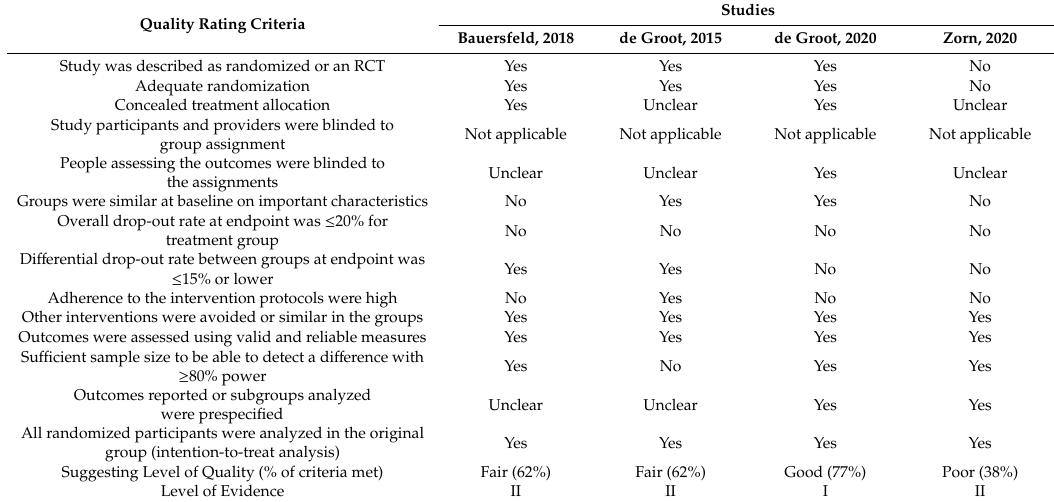
Table 5. Quality and Evidence Level of Randomized Controlled